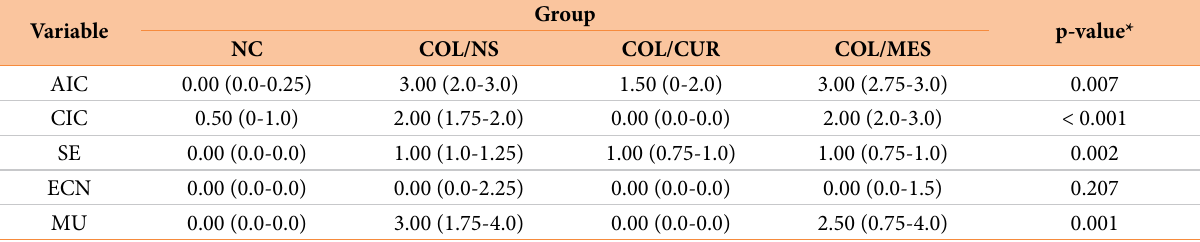
Table 2 - Descriptive and inferential statistics of the histopathological examination.